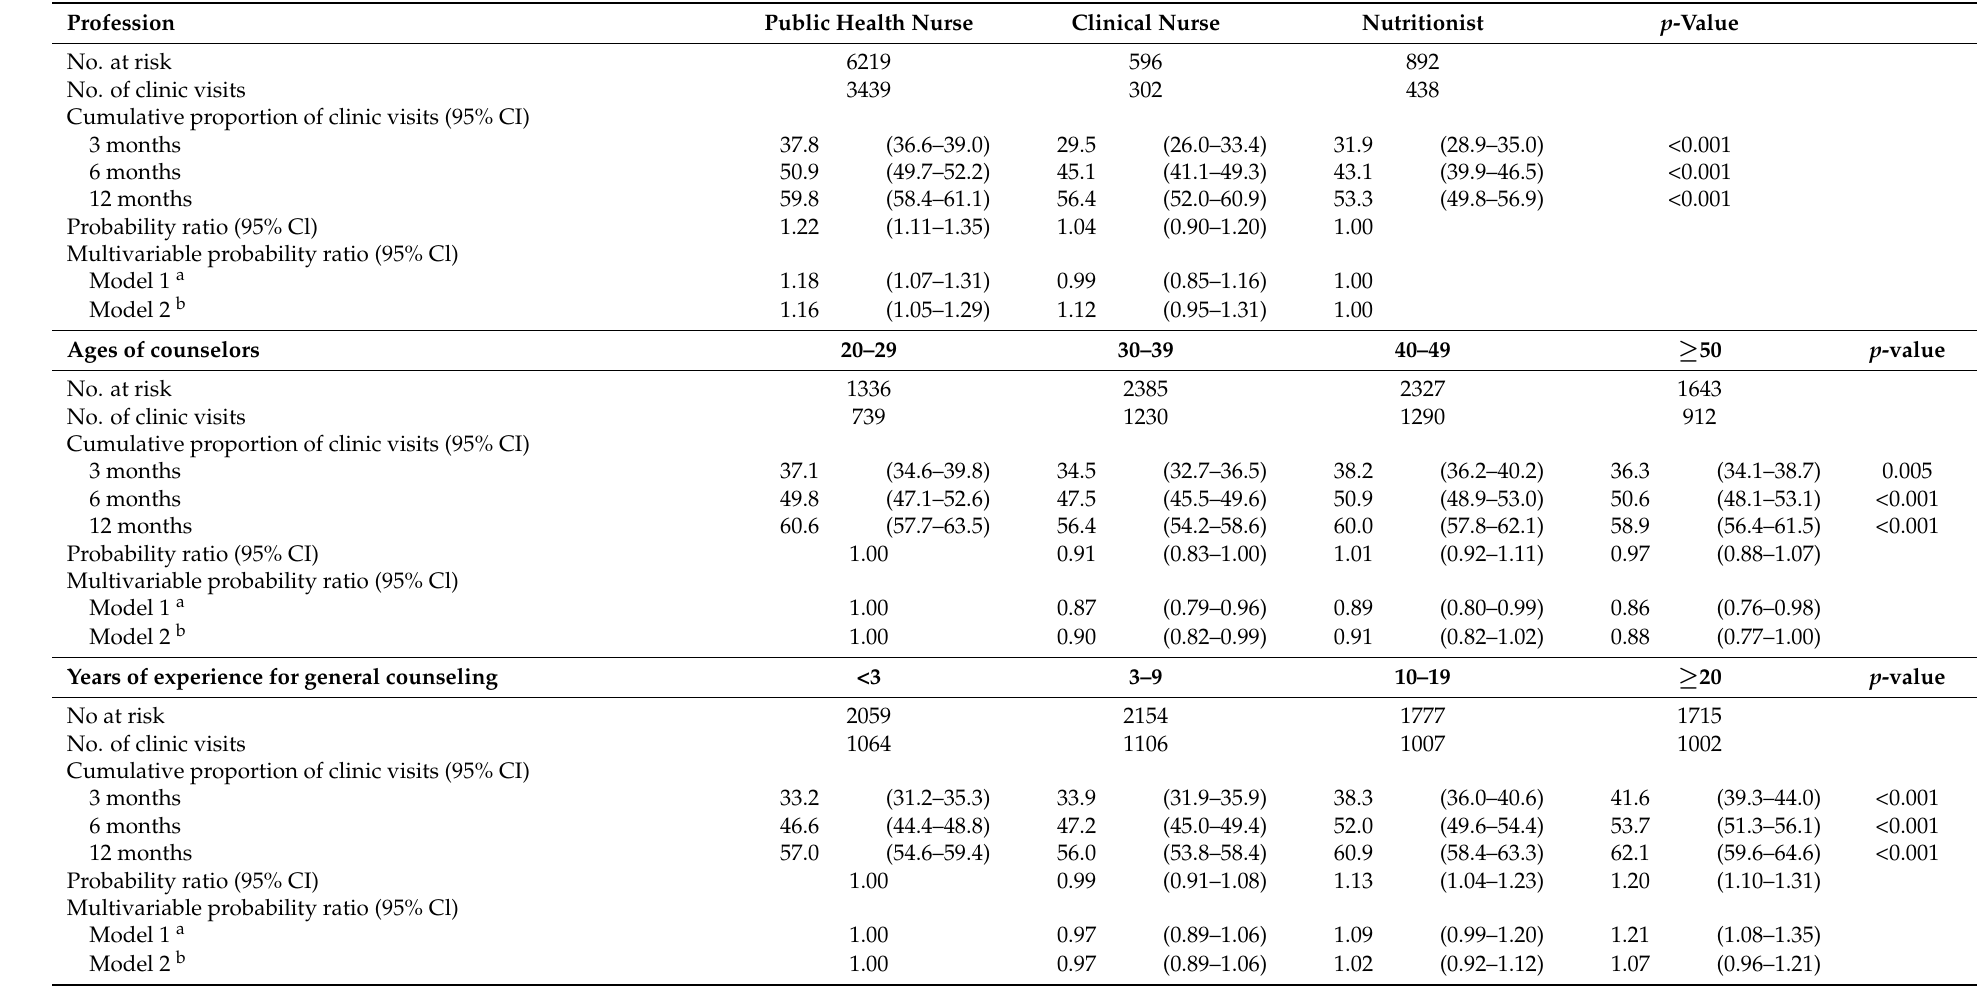
Table 4. Cumulative proportions of clinic visits and probability ratios (95% confidence intervals) according to the counselors’ profession, age of counselors, years of experience for general counseling, and years of experience for lifestyle-related